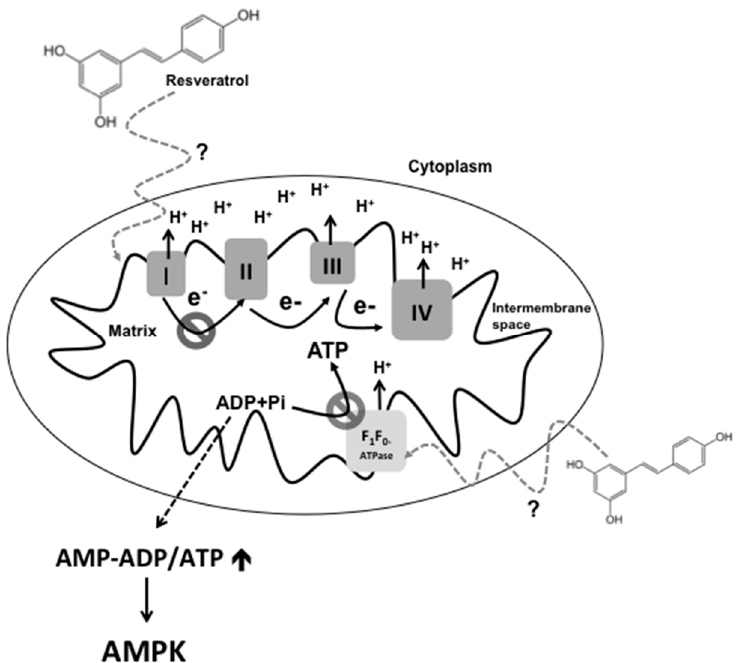
Figure 1. RSV inhibits mitochondrial respiration by a possible interaction with mitochondrial membranes and/or FoF1-ATPase. The possible interaction between RSV and the mitochondrial membrane would disrupt the association of the complex I (I) within the membrane, which, in turn, could inhibit the activity of complex I. On the other hand, RSV inhibits F 1 F 0 -ATPase activity; this might decrease the amount of ATP generated and increase the levels of AMP, which allow the activation of AMPK. Complex II (II), complex III (III) and complex IV (IV). The dashed line and question mark denote an unresolved molecular mechanism.